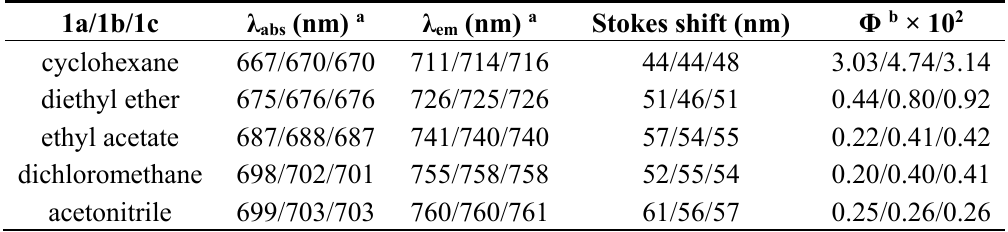
Table 1. Summary of optical absorption and emission properties of 1a – 1c in various